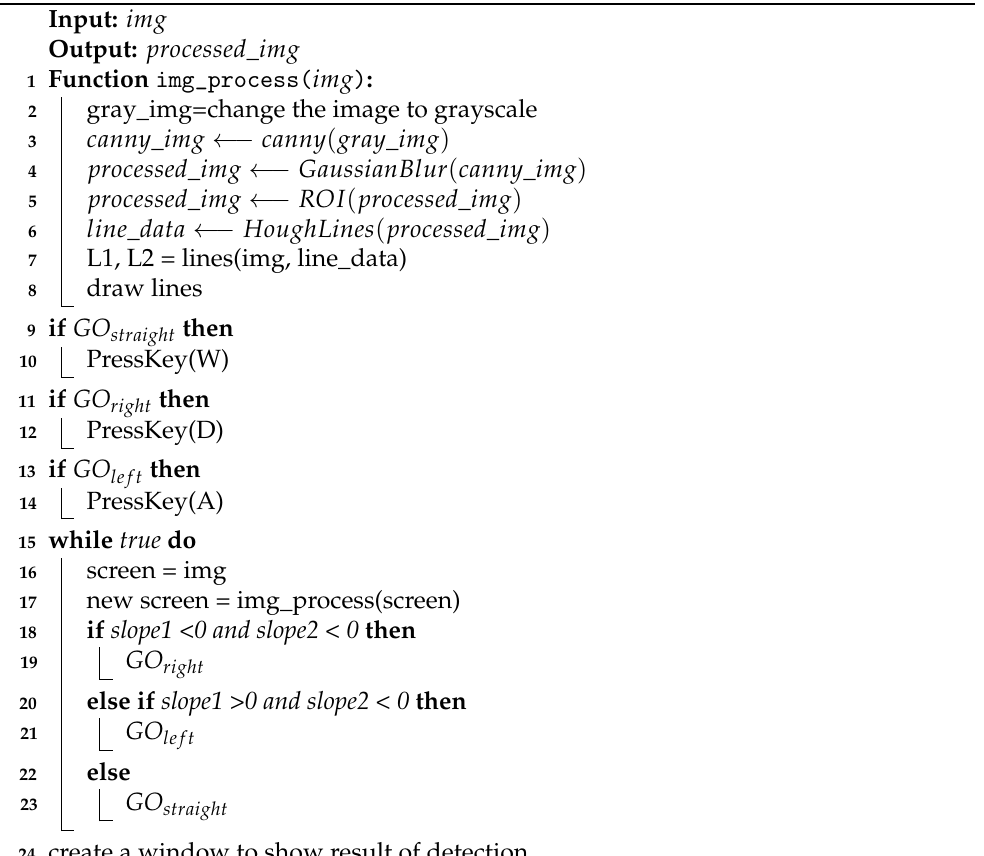
Algorithm 3: Pseudo code of lane detection algorithm-lane-departure